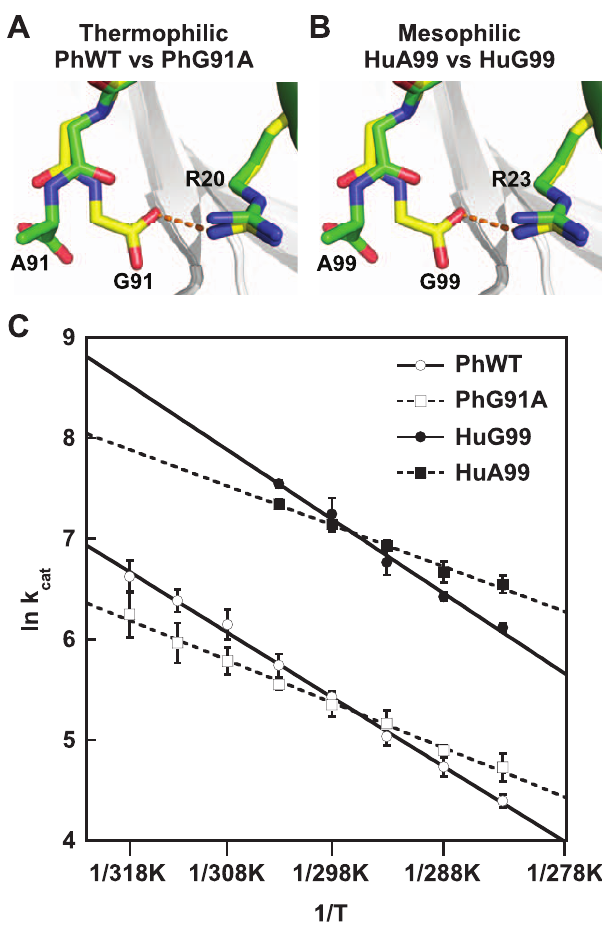
Figure 2. The salt-bridge restraining the active-site arginine residue resulted in a stronger temperature dependency of the acylphosphatase activity. (A) The active-site salt-bridge (orange dotted line) between the guanido group of Arg-20 and the C-terminal carboxyl group of Gly-91 in PhWT (in yellow) is removed in PhG91A (in green). (B) Replacing the C-terminal residue of HuAcP with a glycine residue facilitates the formation of the active-site salt-bridge (orange dotted line) in HuG99 (in yellow). Such salt-bridge is absent in the pseudo-wild-type HuA99 (in green). (C) The Arrhenius plots for PhWT (open circle), PhG91A (open square), HuG99 (filled circle), and HuA99 (filled square). The data showed that the salt-bridge bearing acylpho- sphatases (PhWT and HuG99, solid line) had a steeper slope than the variants (PhG91A and HuA99, dotted line) lacking the salt-bridge.